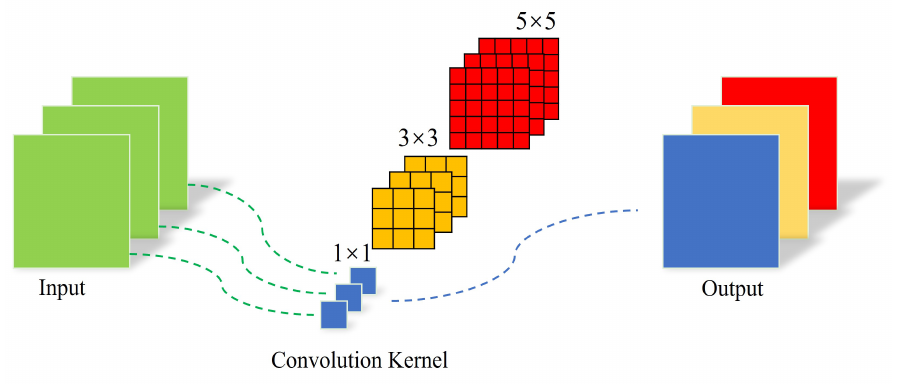
Figure 4. Convolution operation diagram of the EfficientNet network. The convolution kernel sizes of the network model are all the same.